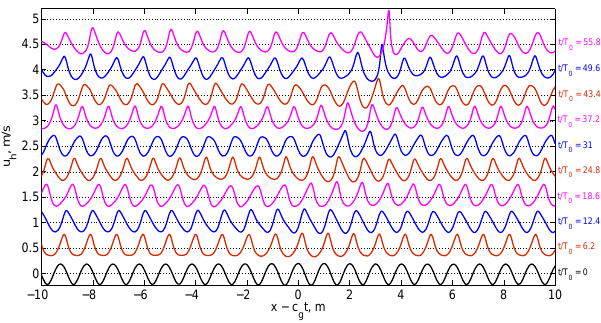
Figure 3. The temporal evolution of the horizontal fluid velocity in a moving reference frame; wave parameters as in Fig.